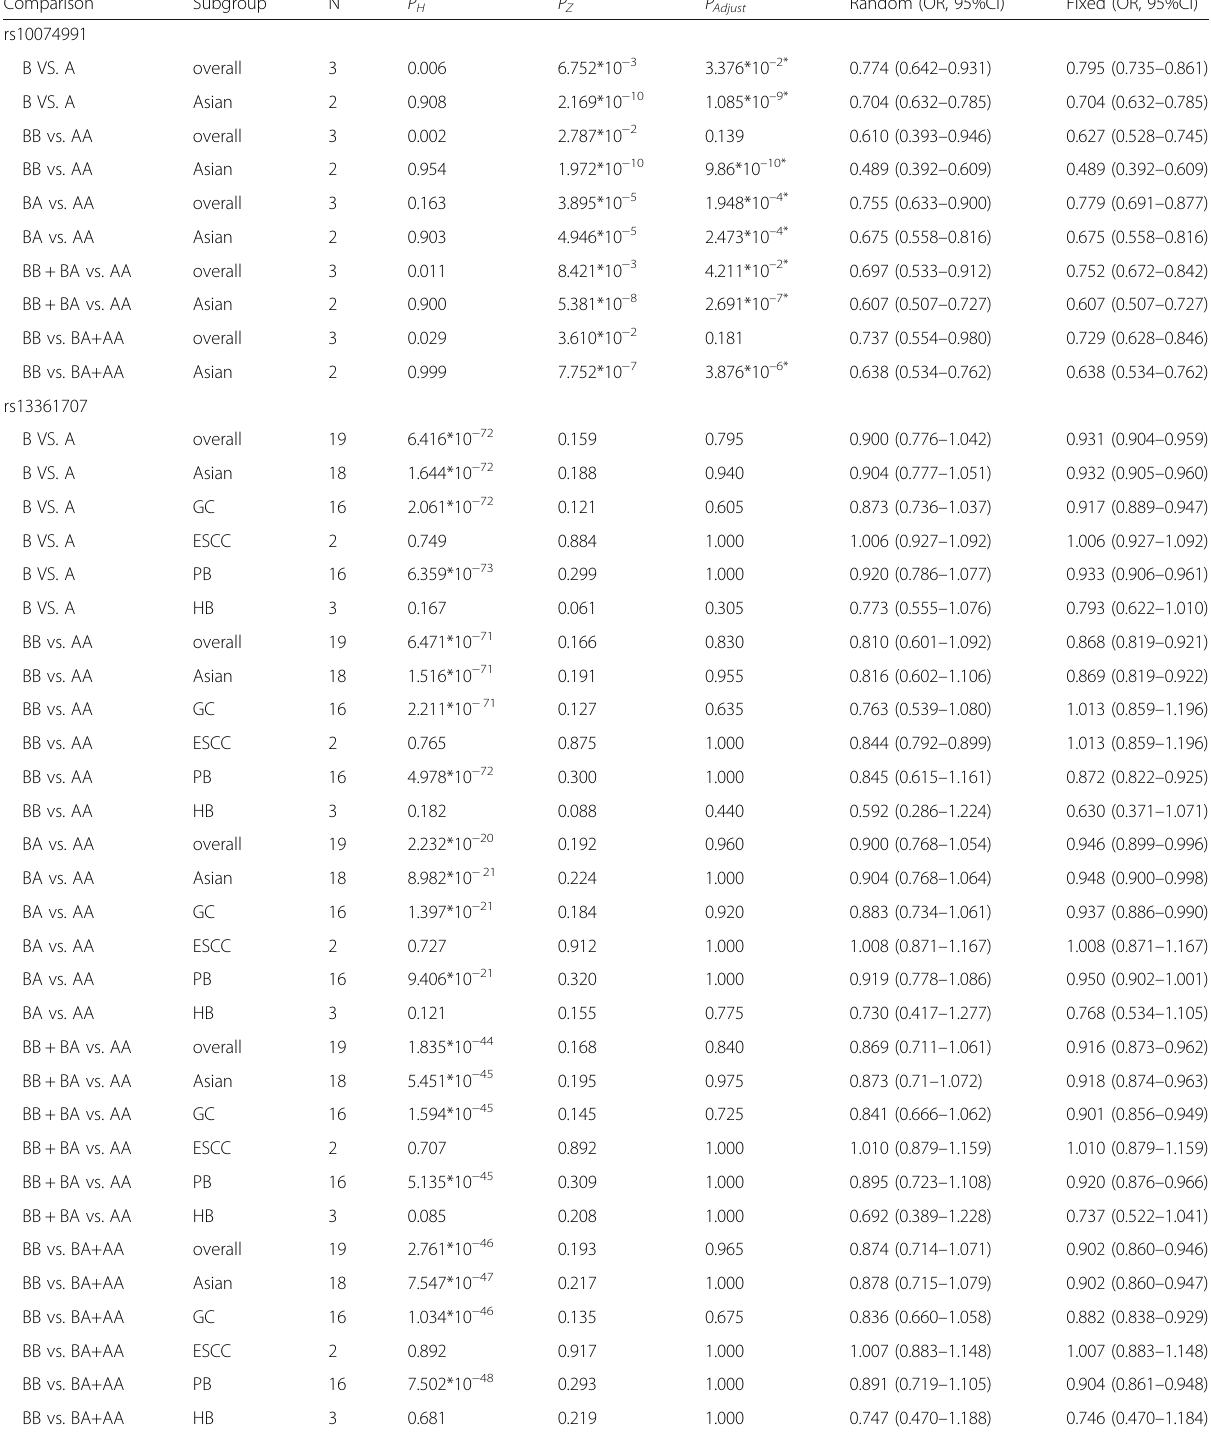
Table 2 Results of meta-analysis for polymorphisms in and cancer